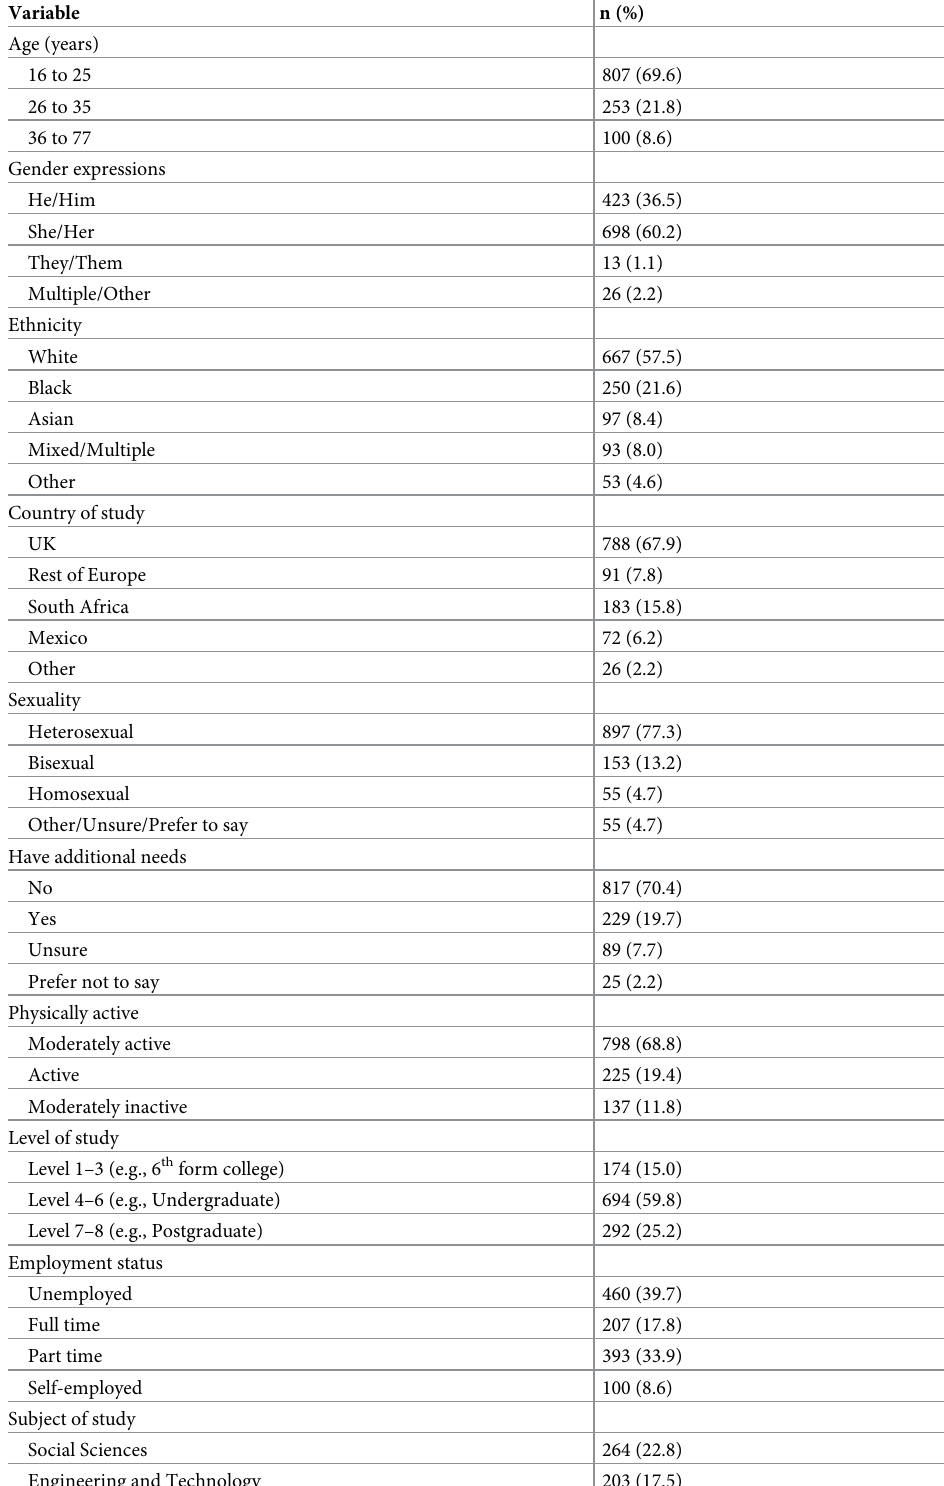
Table 1. Characteristics of the study